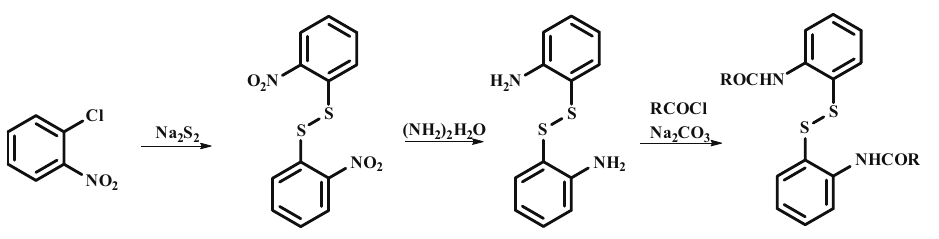
Figure 1: Synthetic route to o -